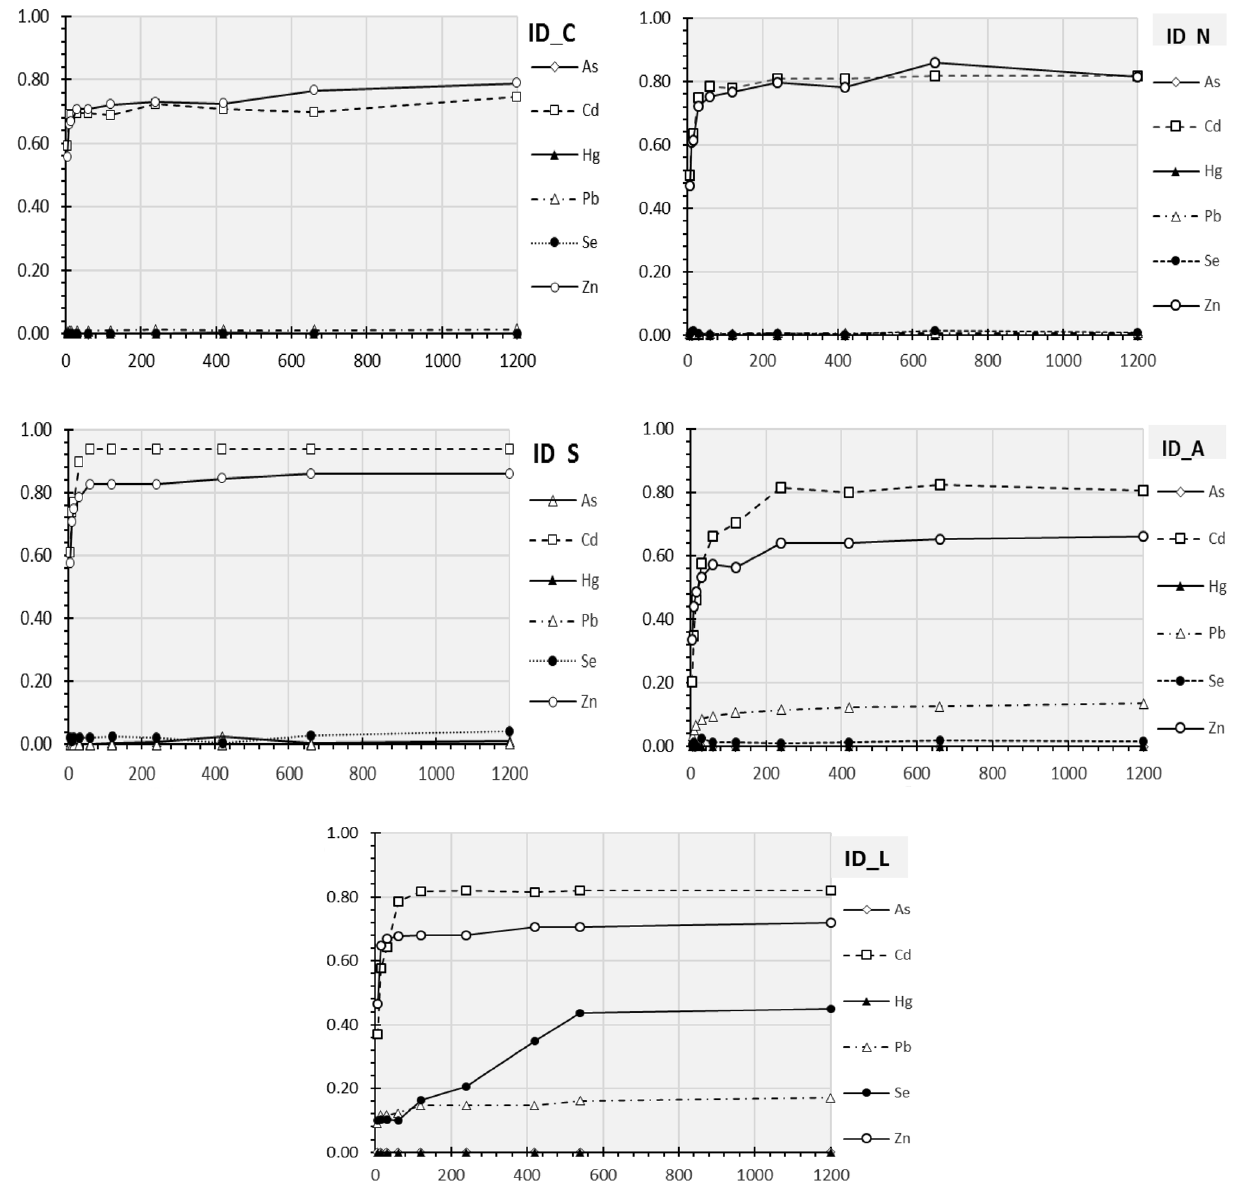
Fig. 5 Kinetics of the five batch-leaching tests: extraction yield versus time